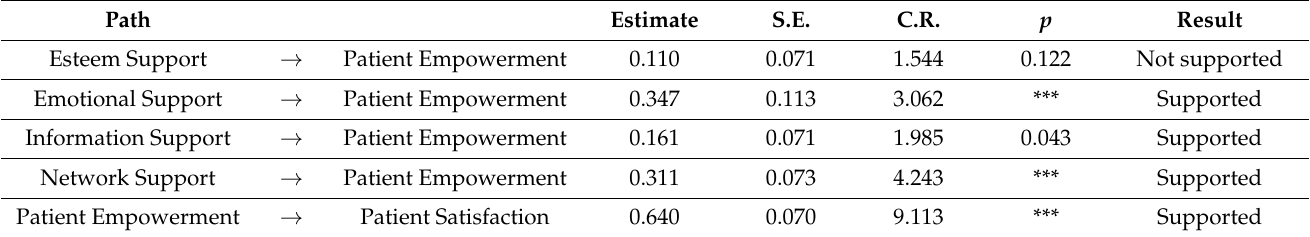
Table 6. Hypothesis